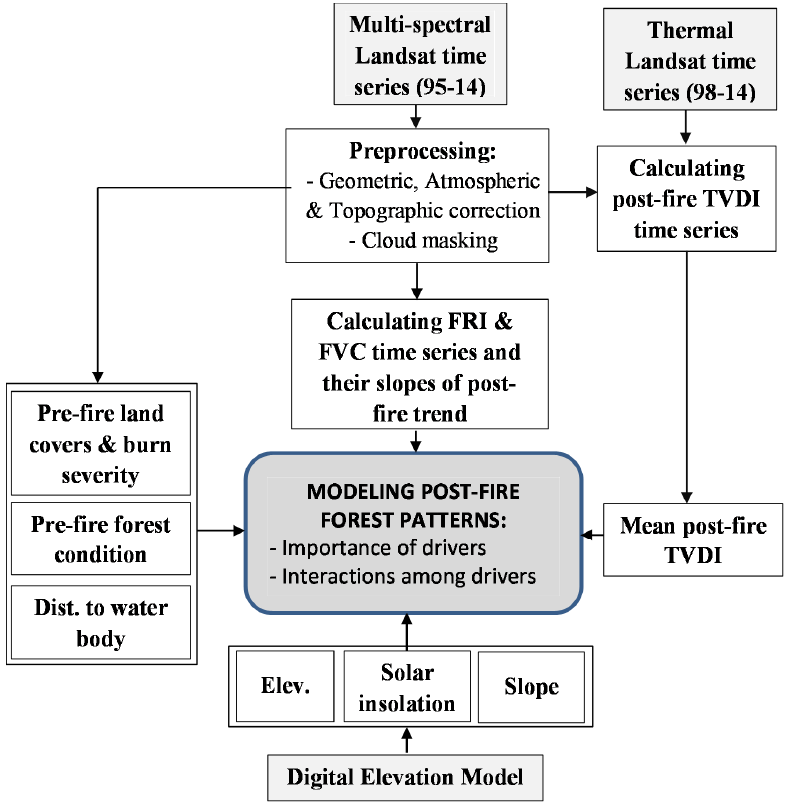
Figure 4. Overall processing flow of modeling drivers of the post-fire forest regeneration in the Siberian boreal Larch forest.